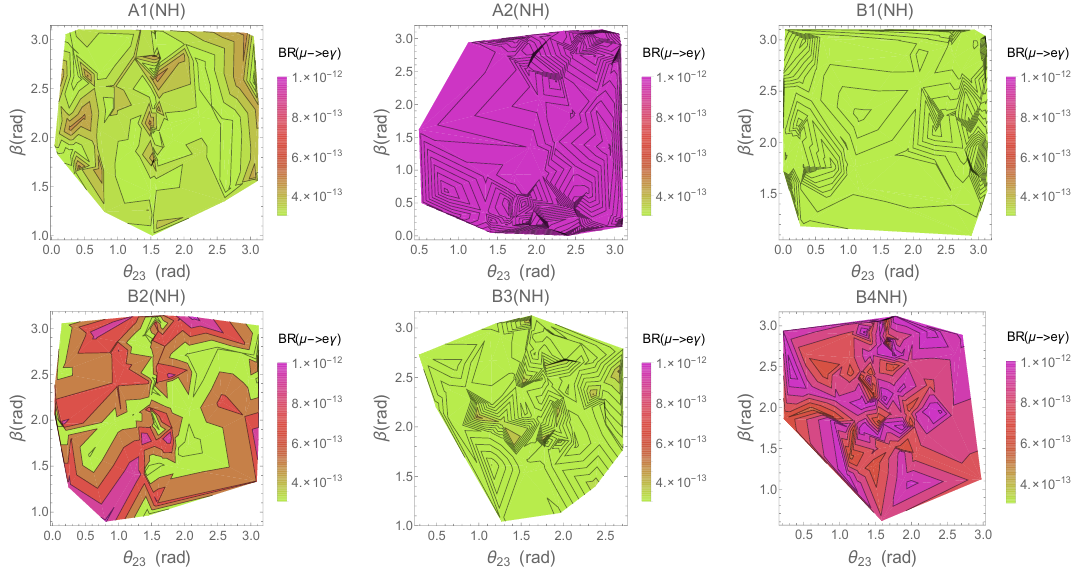
Figure 20 . Atmospheric mixing angle, (cid:18) 23 Vs Majorana phase (cid:11) (for NH) with BR for (cid:22) ! e (cid:13) as the contour where 4 : 2 (cid:2) 10 (cid:0) 13 is the upperlimit for BR given by MEG experiment.